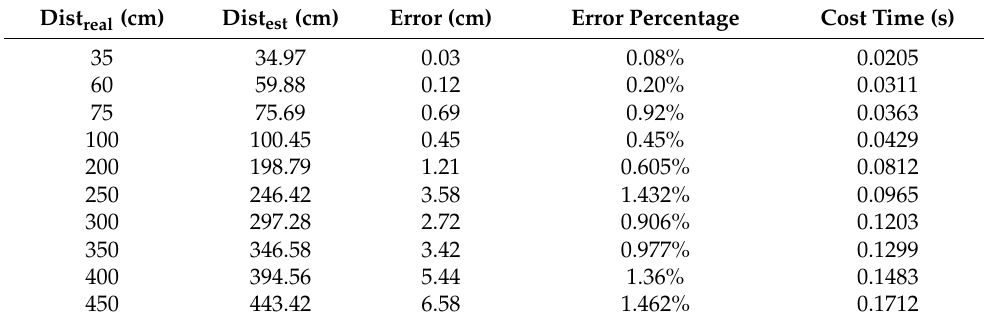
Table 1. The HC-SR04 sensor, with a filter